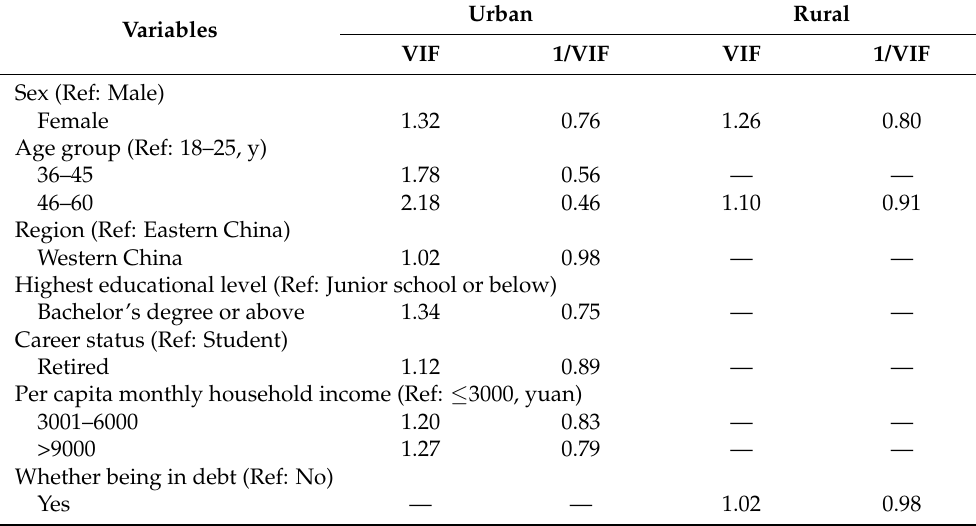
Table A10. The variance inflation factor of variables in stepwise regression analysis stratified by place of